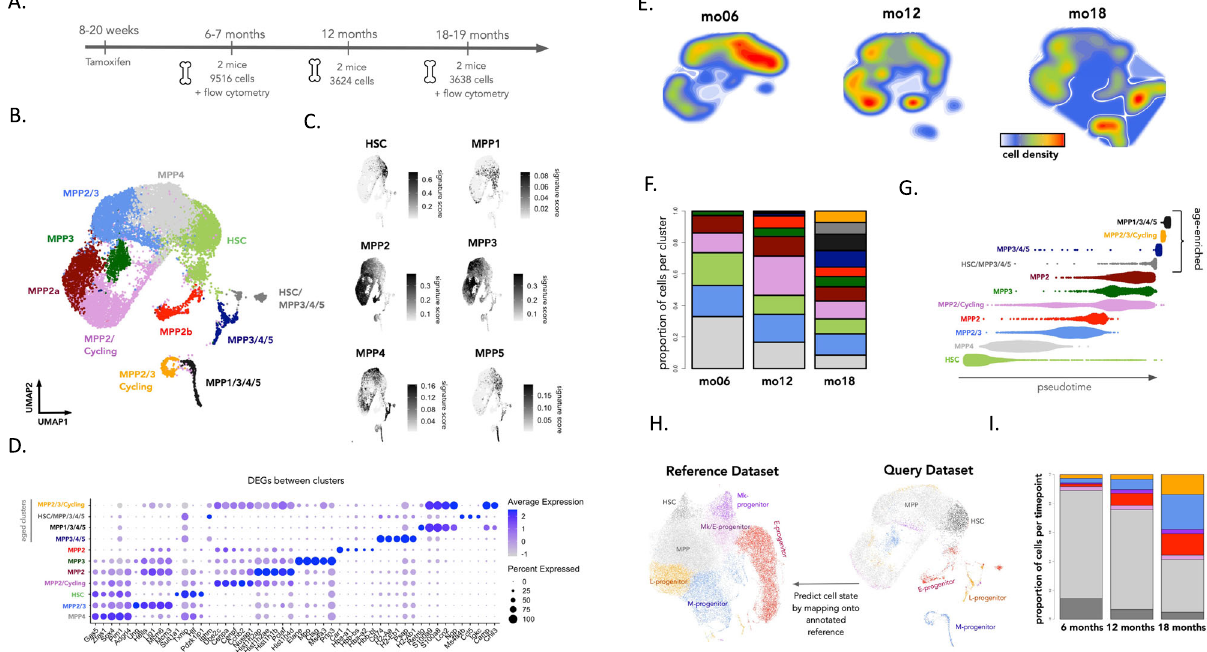
Fig.5|Age-relatedchangesincellularcompositionoftheHSPCcompartment. A Experimental timeline for pro fi ling HSPCs across adulthood. Male DRAG mice were given tamoxifen at 8 – 20 weeks of age to induce barcode recombination. At subsequent time points, HSPCs were puri fi ed from the bone marrow of induced mice and processed for scRNAseq or fl ow cytometry analysis. For each time point, we give the number of mice processed aswellasthe numberofcells recovered for scRNAseq pro fi ling. B UMAP embedding of the scRNAseq data. Unsupervised clustering was used to discretize the data into colored subgroups, and cluster annotation was performed by overlaying published gene signatures and markers 26,27,32 . C Overlaying published gene signatures 27,32 onto the UMAP embed- dingofthedata.Foreachcell,thegenesignaturescorewascalculatedasthemean expression across all genes in the signature (after background correction). D Top fi ve differentially expressed genes for each cluster. Differential gene expression analysis was performed using a logistic regression test as implemented in the Seurat R package, and Bonferroni correction was applied to account for multiple testing. E Density plot showing the proportional abundance of cells within the